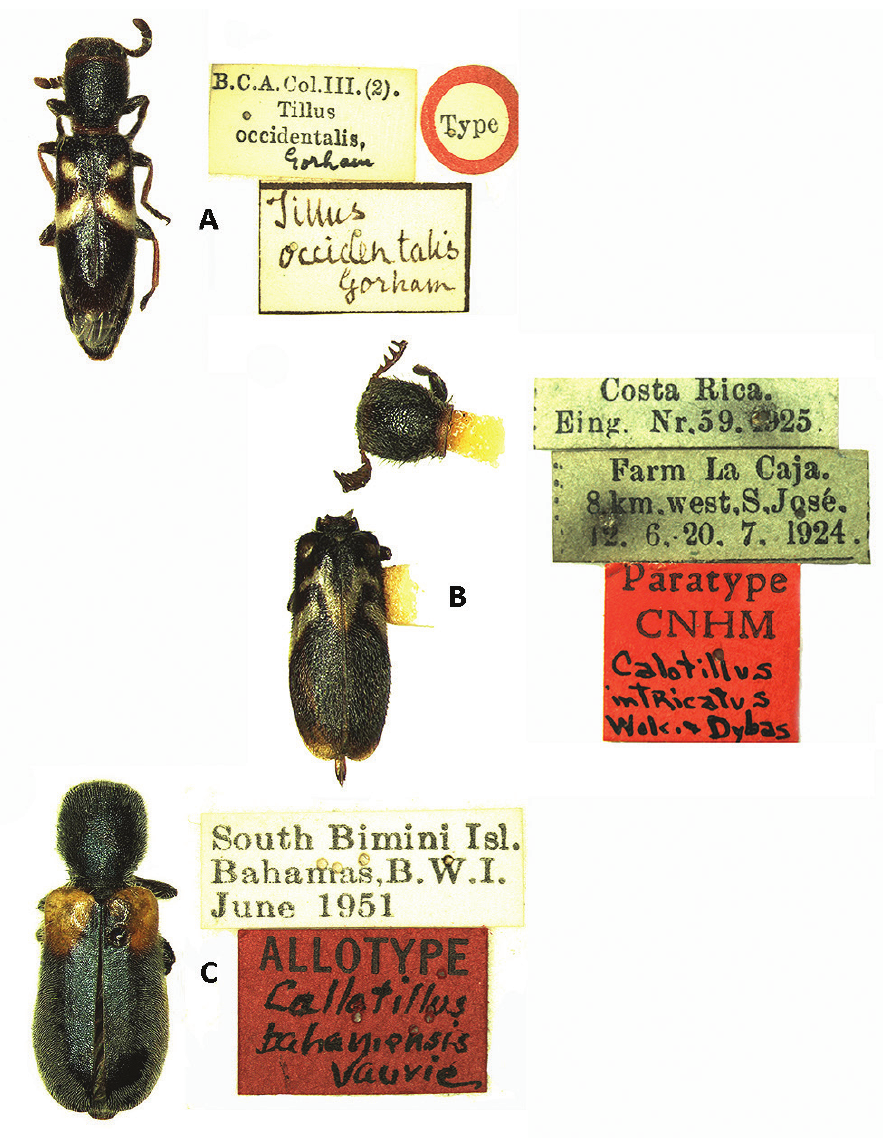
Figure 2. Types and corresponding labels of: A Tillus occidentalis (Gorham) [ Neocallotillus elegans ], fe- male B Callotillus intricatus (Wolcott and Dybas) [ Neocallotillus intricatus ], male C Callotillus bahamensis Vaurie,